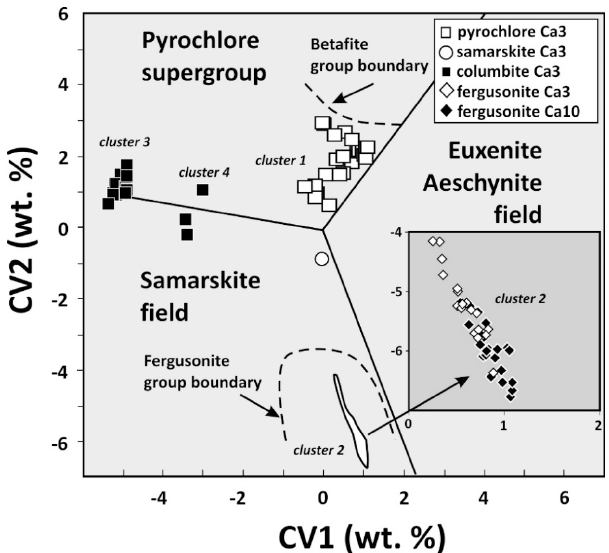
Figure 5. Discrimination plot for pyrochlore-, samarskite-, fergusonite- and euxenite–aeschynite group minerals [38] with projections of EPMA data from Č amovce. CV1 = 0.245Na 2 O + 0.106CaO – 0.077 Fe * + 0.425PbO + 0.22Y 2 O 3 + 0.28LREE 2 O 3 + 0.137HREE 2 O 3 + 0.1 U * + 0.304TiO 2 + 0.097Nb 2 O 5 + 0.109 Ta *